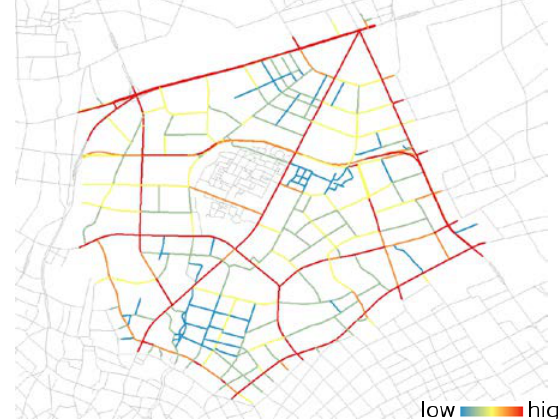
Figure 13. Extended betweenness centrality values with the generated ODs in Figure 12.